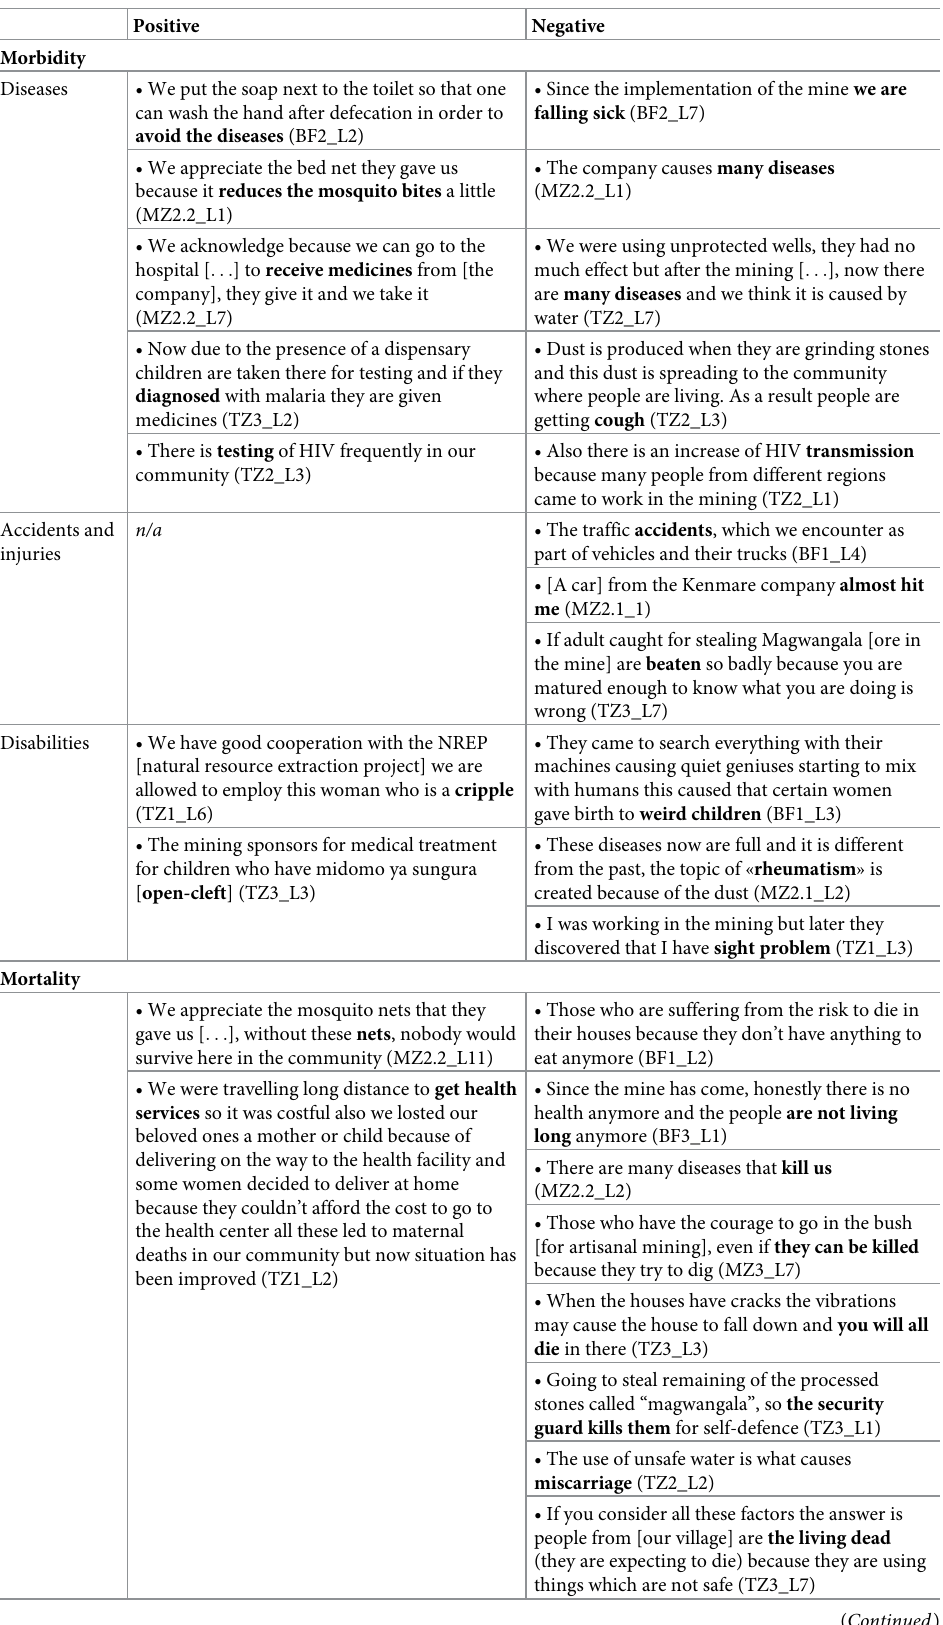
Table 3. Exemplary quotations of coded health